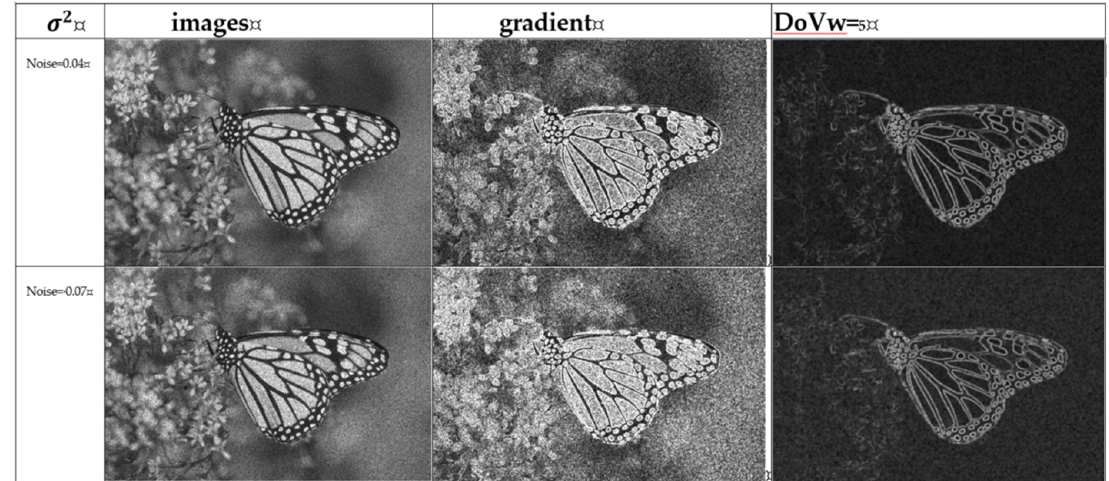
Figure 5. The outcome of the difference of variances (DoV) in different speckle noise.